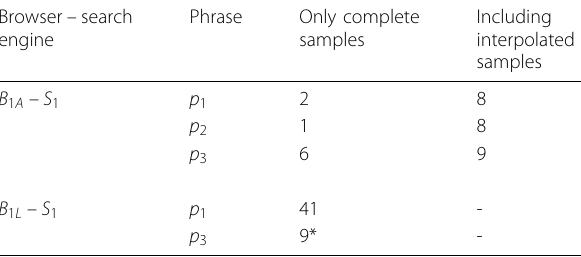
sorted by timestamp. The data is pre-processed in all the possible permutations of including interpolations and/or balancing